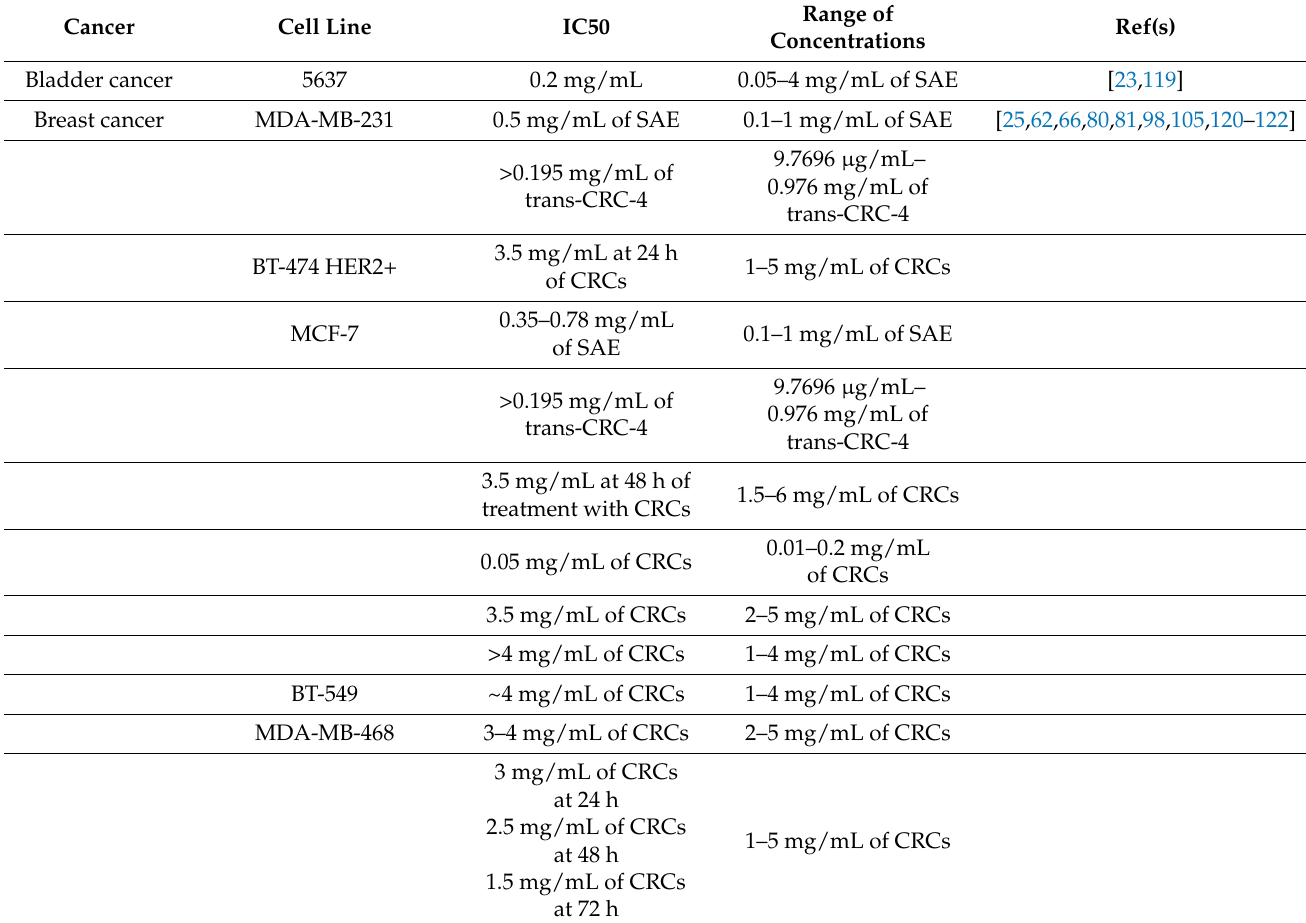
Table 2. Antiproliferative effect of CRCs and DMCRT on several cell